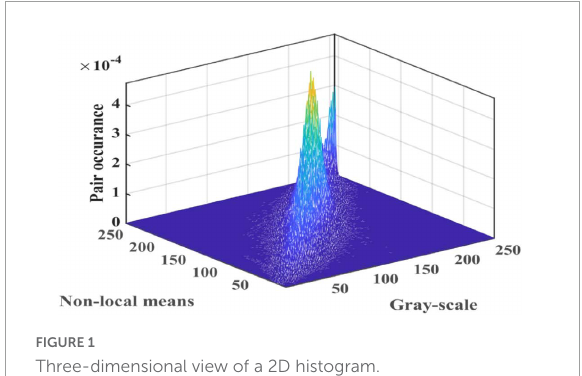
FIGURE1 Three-dimensional view of a 2D histogram.